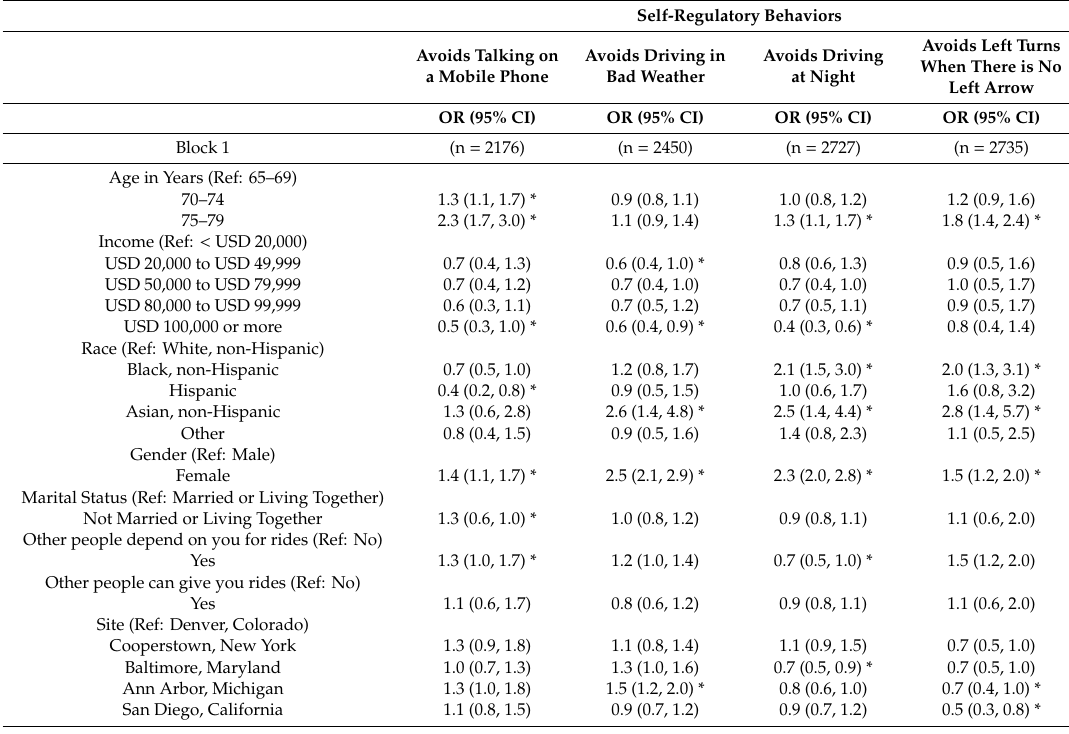
Table 5. Adjusted Odds Ratios (ORs) and 95% Confidence Intervals (CIs) from Hierarchical Logistic Regressions Exploring Relationship of In-Vehicle Technologies and Self-Regulation (Block 1).